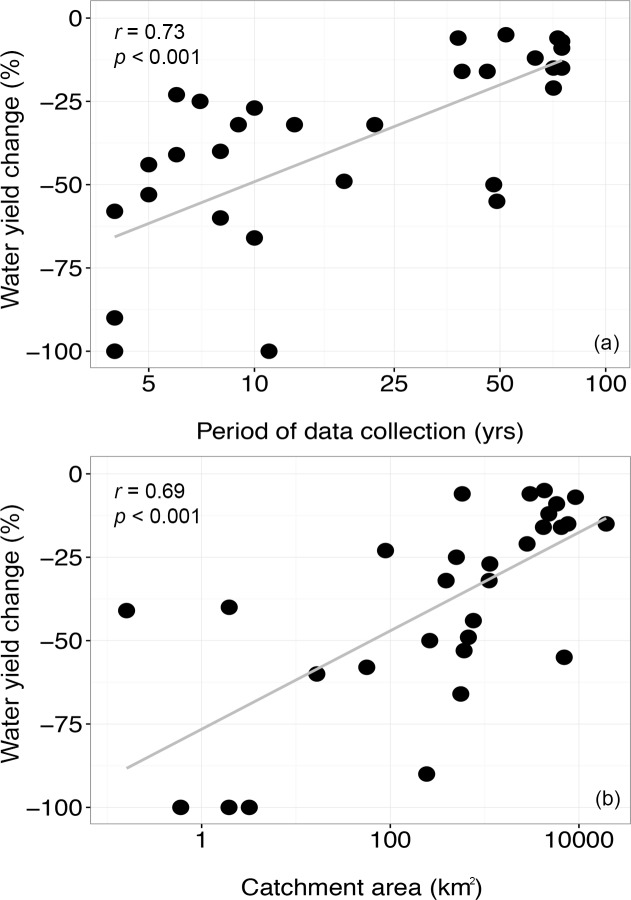
Meta-analyses of water yield response versus temporal and spatial scale of studies.Scatter plots with percentage change (decline) in water yield versus period of data collection (a) and catchment size in km2 (b). The data included are from a subset of study cases selected for meta-analyses, and the x-axis are log10 scaled. Spearman correlation results are indicated for both datasets.